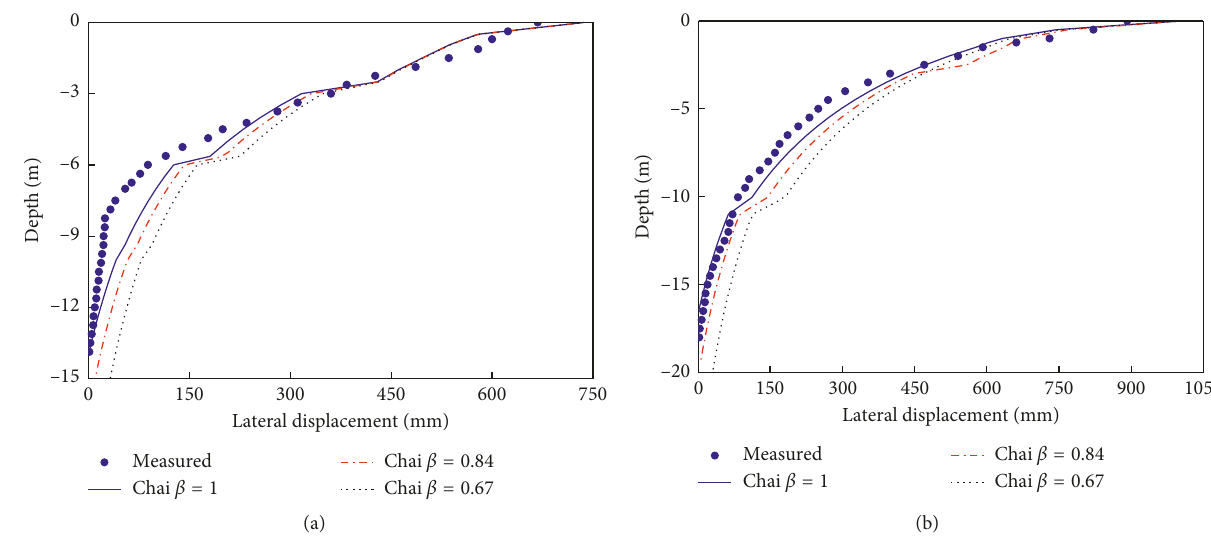
Figure 6: Lateral displacement of soil at treated area. (a) Section 1 and (b) Section